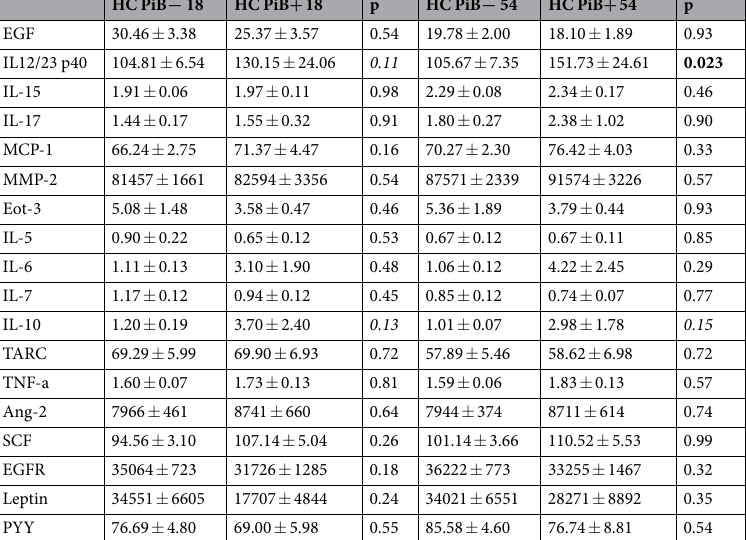
Table 8. General Linear Model analysis of the biomarkers in HC according to brain amyloid deposition (PiB − , SUVR < 1.5 and PiB + , SUVR > 1.5) at 18 and 54 month time points. Data are presented as Mean ± S.E., although statistical analysis was performed on the log 10 value to better approximate a normal distribution. For IL-5, IL-6 and IL-17 the log 10 conversion was performed on the (raw data + 1) in order to accommodate 0 values.